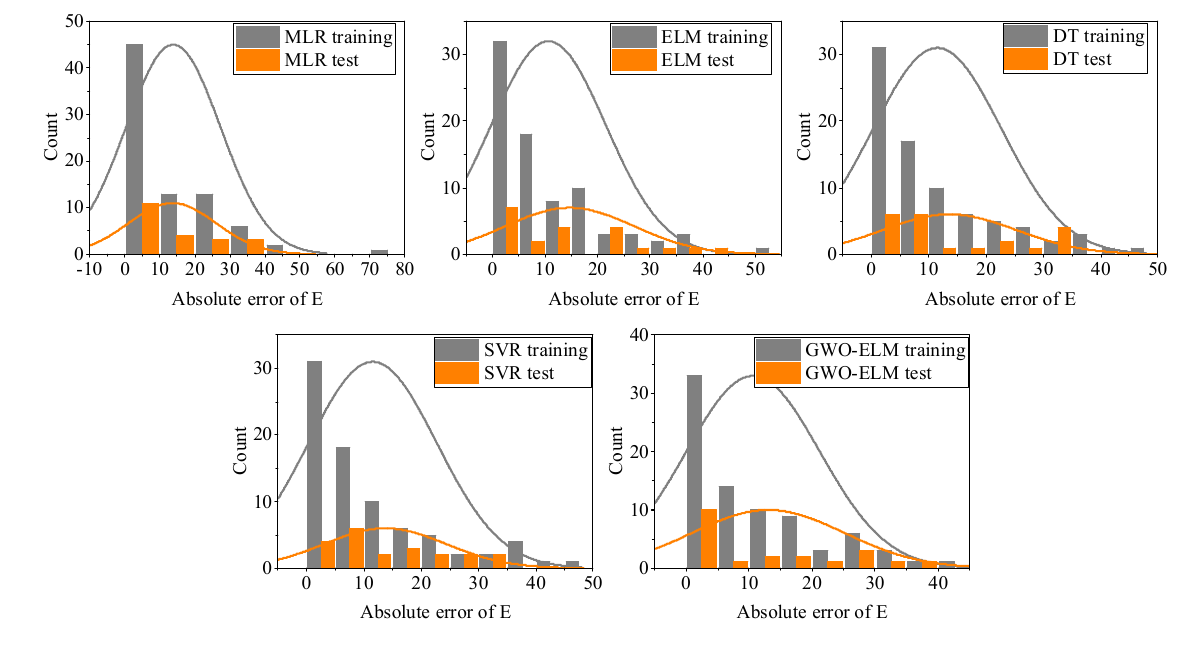
Figure 12. Prediction error distribution of different models for E.